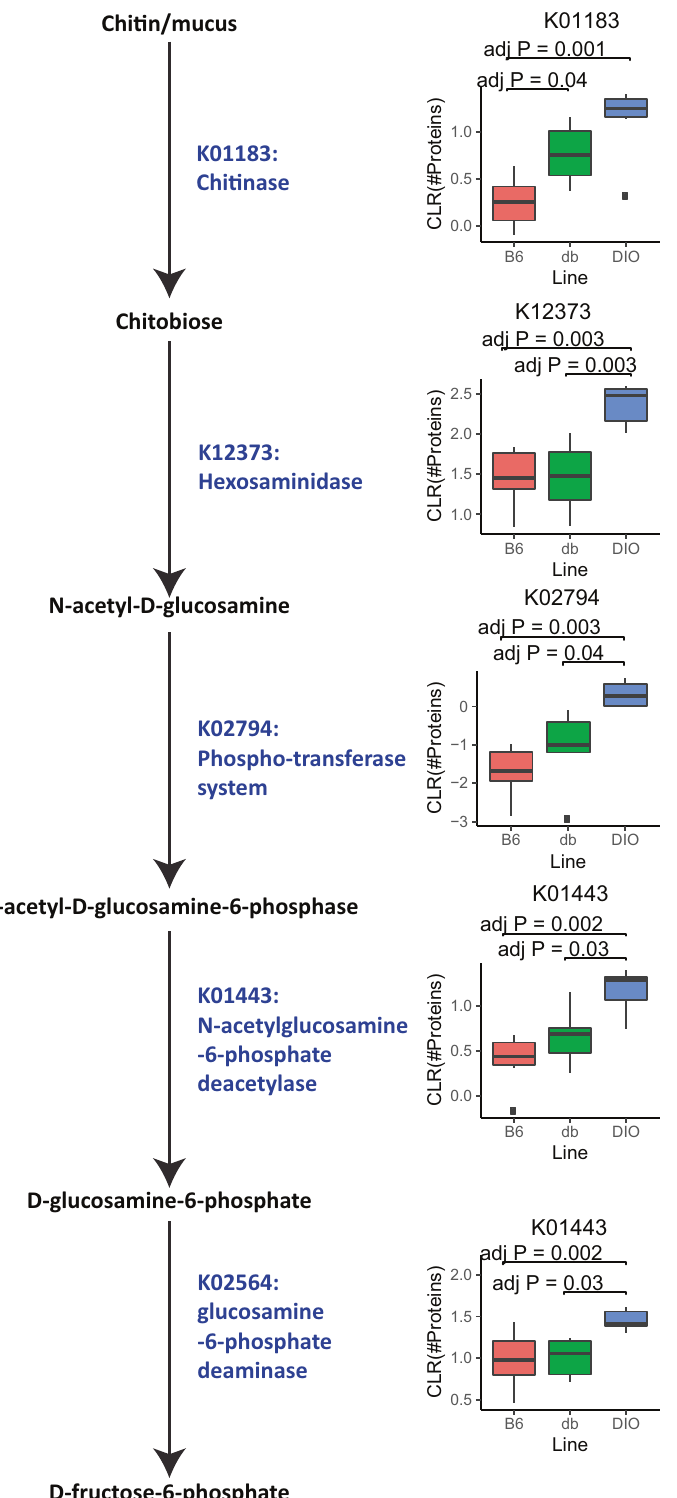
Fig. 5 Total proteins in KEGG orthologs reveals a complete pathway from mucus to D-Fructose 6-phosphate that is more abundant in DIO than B6 or db/db mice. Proposed pathway from mucin to fructose-6-phosphate supported by boxplots of CLR normalized protein counts of KEGG orthologs associated with the pathway. All KO terms were signi fi cant with a TukeyHSD adjusted P value < 0.05 between DIO and B6 and/or db/db. All KO terms, except K02564 were signi fi cant by two-way ANOVA (Q < 0.25). Only a single signi fi cant digit was reported.